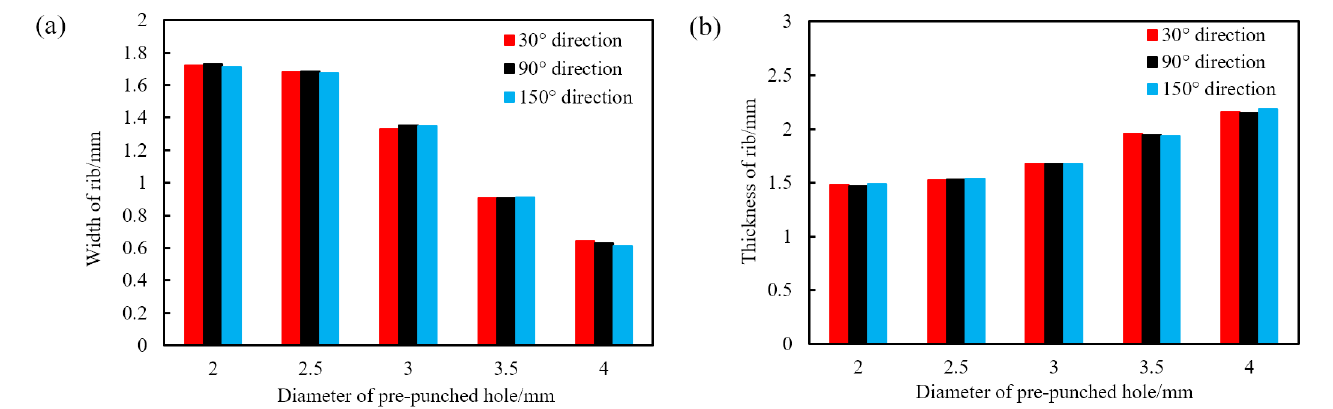
Figure 5. Rib width and thickness of an industrial PP triaxial geogrid with different pre-punched holes. ( a ) Width, ( b )